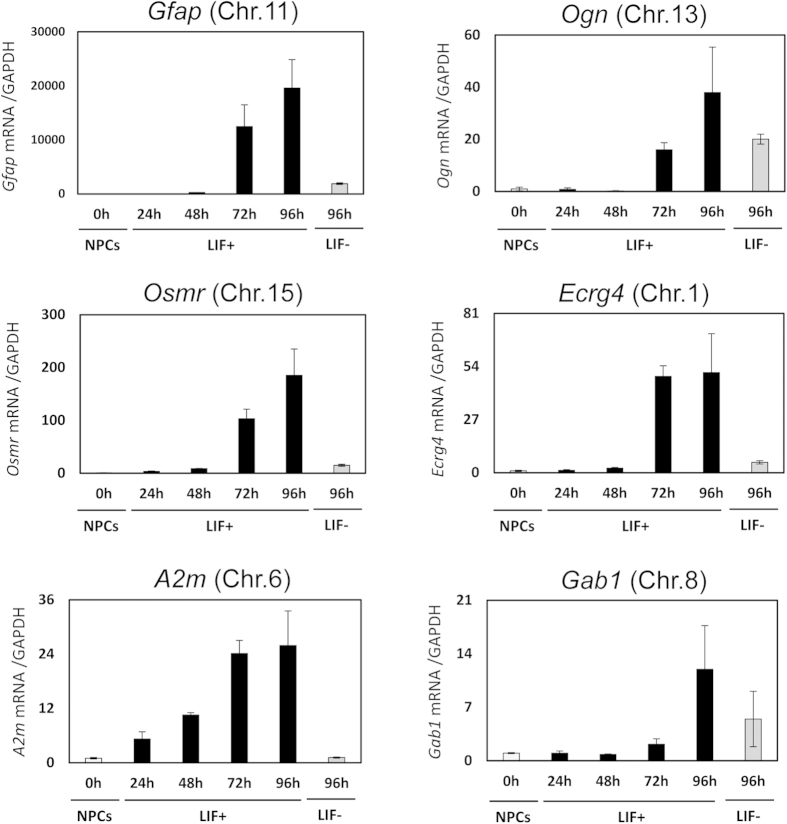
Validation in expression of Gfap and five putative genes identified by Genechip and modified e4C.Quantitative RT-PCR was performed on Gfap and five genes selected from modified e4C. The expression level of each gene was determined in NPCs (NPCs 0 h), cells stimulated with LIF for different periods of time (LIF+ 24 h, 48 h, 72 h, 96 h), and without LIF (LIF− 96 h). The results were normalized to Gapdh expression. Each graph represents the mean (±SEM) relative amount (compared with NPCs) in at least three experiments.